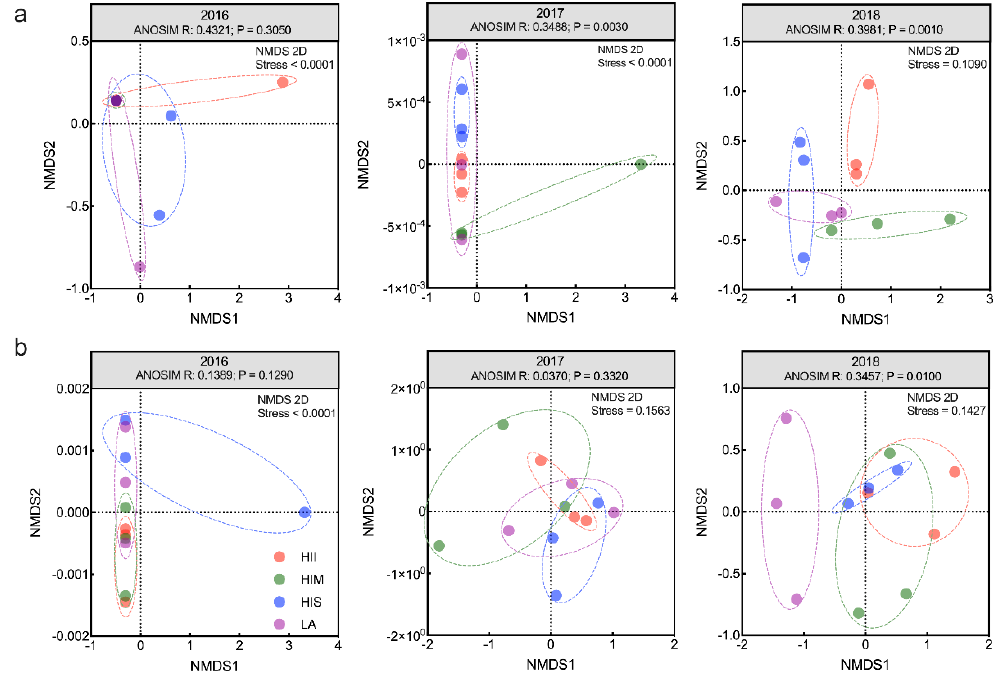
Figure 2. NMDS and ANOSIM of the bacterial community ( a ), and NMDS and ANOSIM of the fungal community ( b ).